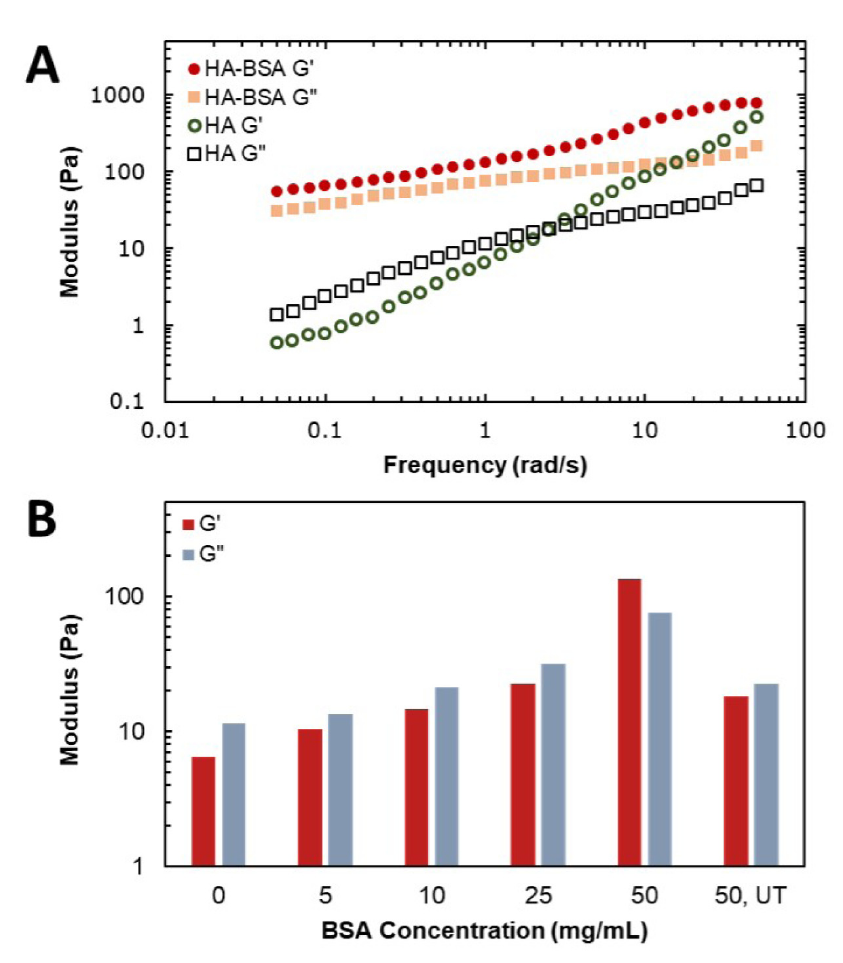
Figure 4. Rheological characterization of HA/BSA systems. ( A ) Oscillatory rheological frequency sweep of HA solution alone (10 mg/mL) and HA/BSA gel (BSA: 50 mg/mL). ( B ) Storage (G’) and loss (G”) moduli of HA (10 mg/mL) with various concentrations of BSA at 1 rad/s. UT = untreated BSA. Dataset 1: Rheology